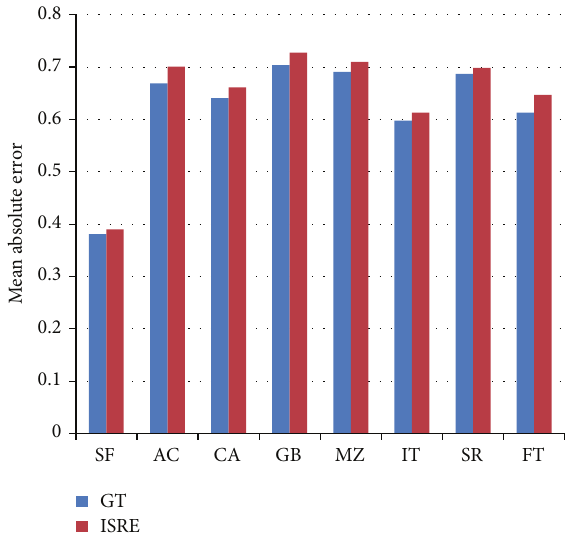
Figure 6: Comparison of mean absolute error relative to ISRE and GT.